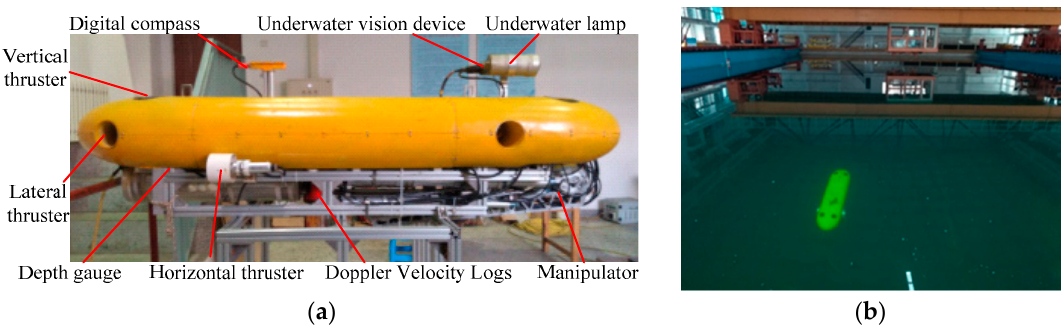
Figure 6. UVIC-I AUV and its autonomous operations in the pool. ( a ) UVIC-I prototype vehicle; and, ( b ) UVIC-I AUV during autonomous operations in the pool.